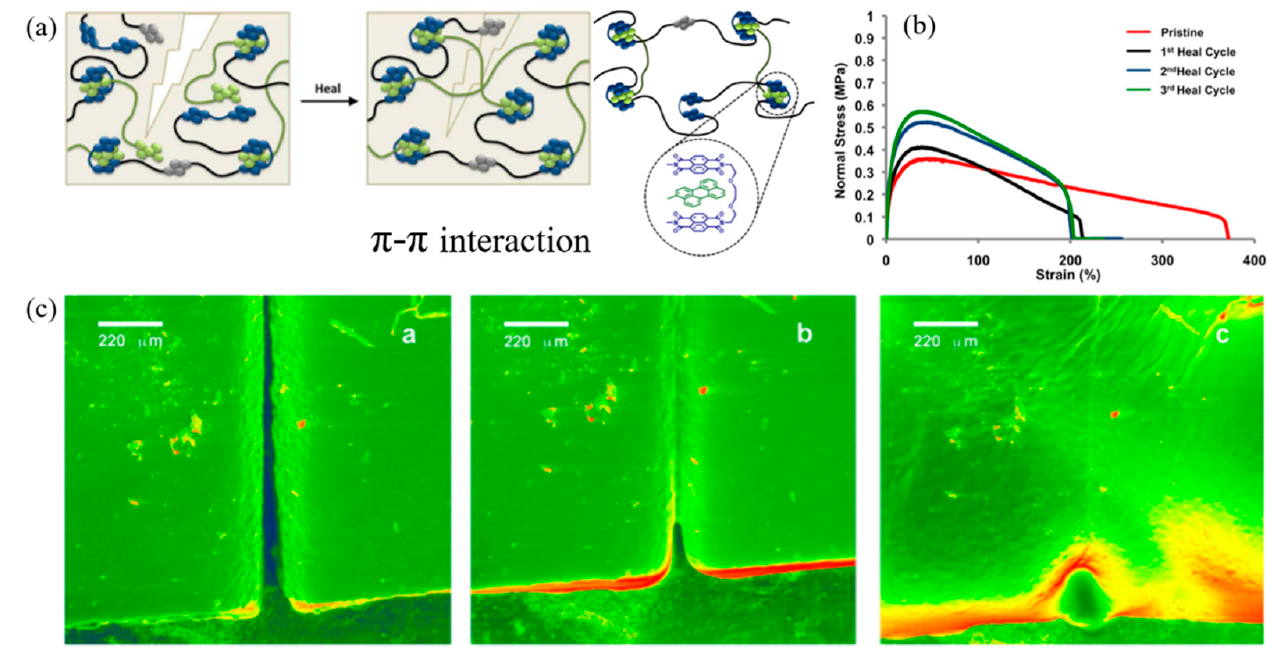
Figure 17. The self-healing model in perylene polymer and chain-folding polydiimide; ( a ) healing mechanism in polymer chain with π – π interaction, ( b ) stress–strain curves of pristine and samples with various healing cycles, and ( c ) ESEM images of healing polymer with π – π interaction (a: 25 °C, b: 75 °C, c: 125 °C) [103]. Adapted from [103], Copyright 2015, with permission from Elsevier. The characteristics of π – π interaction for self-healing processes were investigated using FT-IR, and UV/VIS spectroscopy, which is summarized in Table